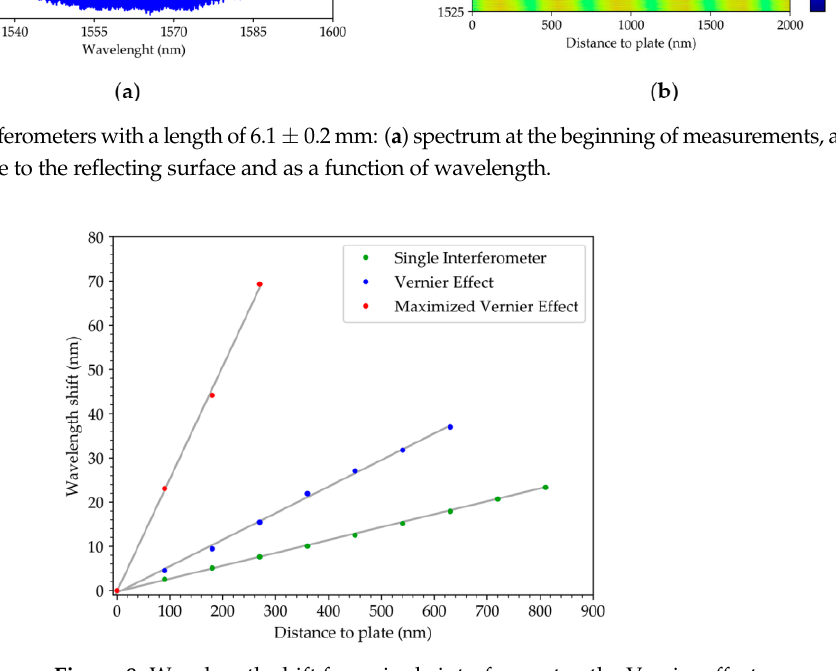
Figure 8. Wavelength shift for a single interferometer, the Vernier effect compared to single interfer- ometer and the Vernier effect maximized. The error bars associated with each value are the same dimension as the geometry of the point that represents it. Table 1. Parameters values that characterize the implementation of the enhanced Vernier effect